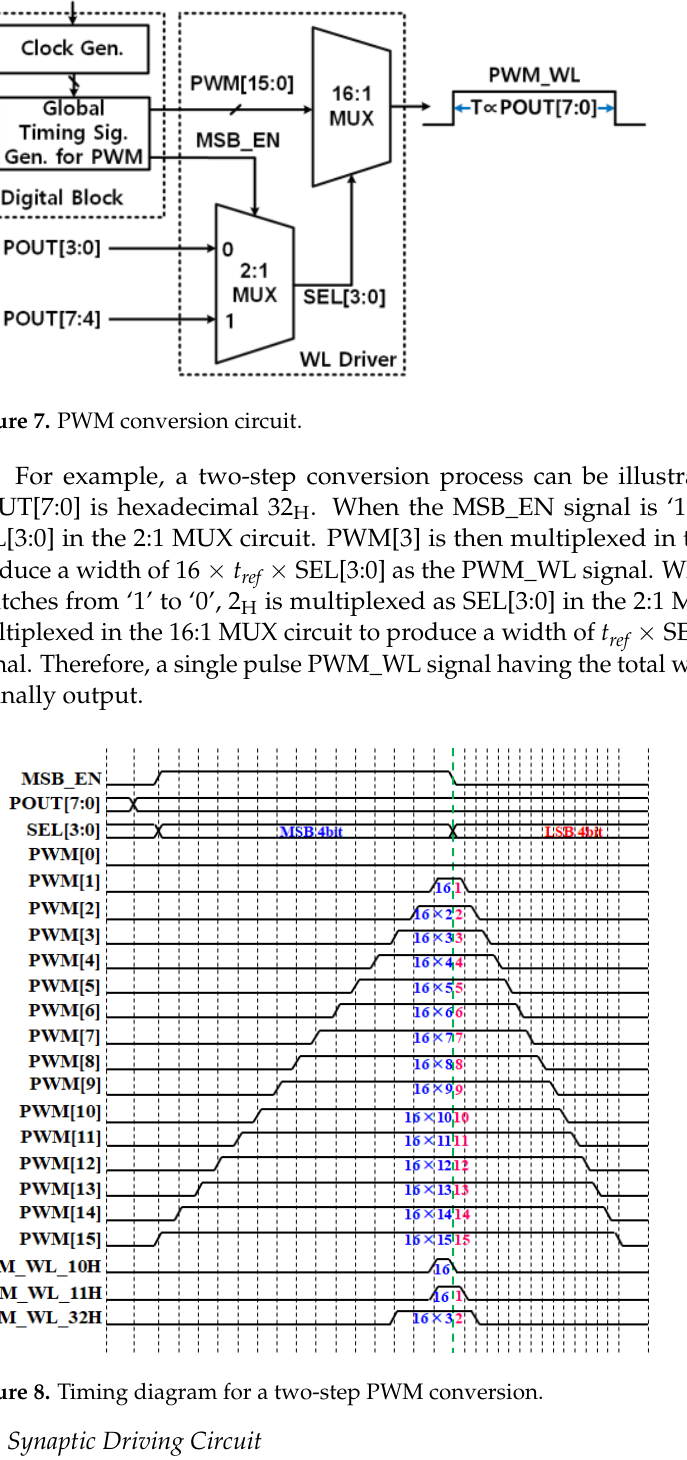
Table 4. Output voltages of HV switching circuit for each operation mode.